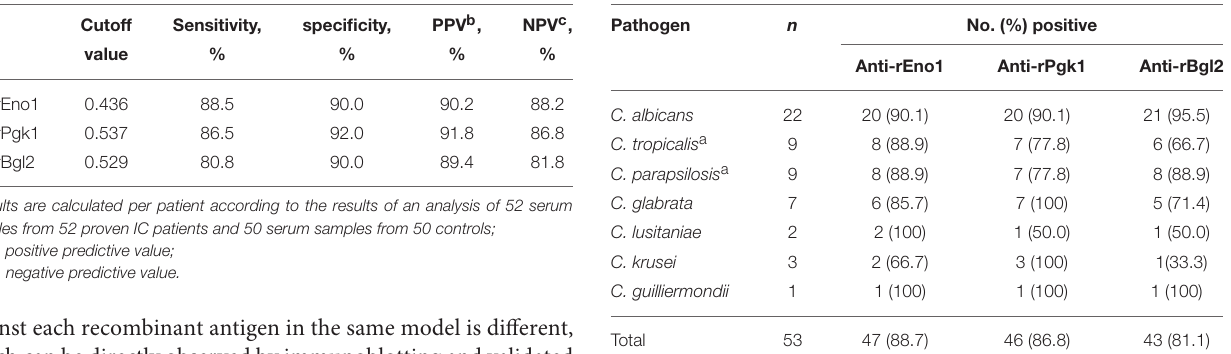
TABLE 4 | IgG antibodies and microbiological surveillance of proven IC